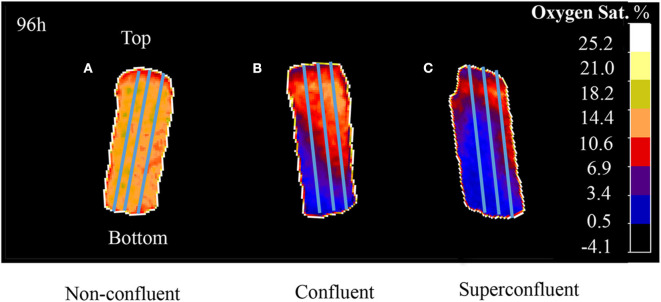
A profiling tool was use to draw triplicates of a line across the entire length of the sensor (from the bottom to the top of the ramp). VisiSens ScientifiCal output for three different degrees of culture confluence: (A) subconfluent, (B) confluent, and (C) superconfluent after 96 h of culture. Initial cell densities used were 3.5 × 104 cells/cm2 for subconfluent, 6.8 × 104 cells/cm2 for confluent, and 1.02 × 105 cells/cm2 for superconfluent cultures.